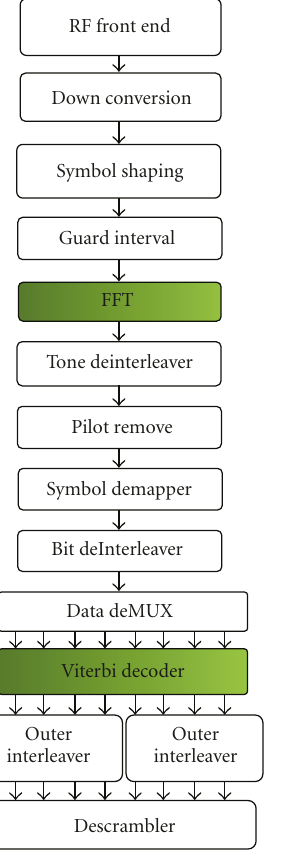
Figure 4: WirelessHD baseband receiver block diagram.